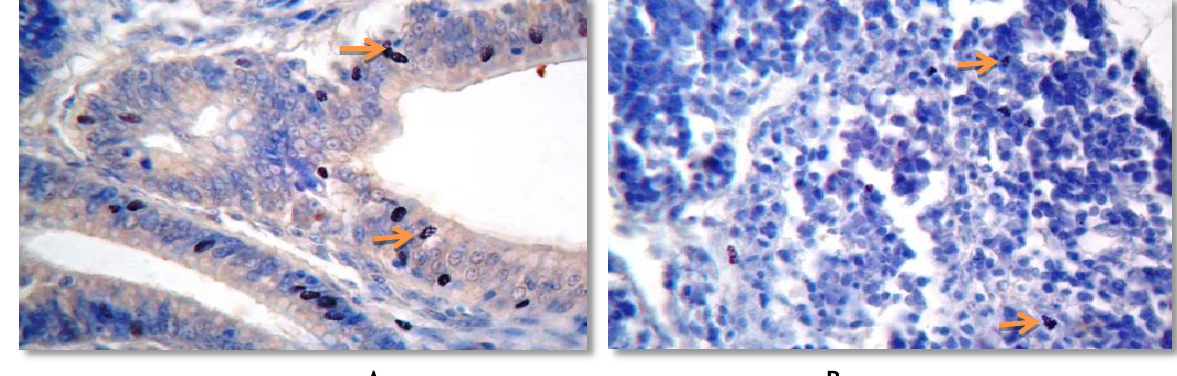
A B Figure,5: Macrophages in paraffin embedded sections (5µm) were identified by using an anti-chicken monocyte- macrophage mouse monoclonal antibody (KUL01) and an HRP –conjugated secondary antibody A:Macrophages in the duodenum of heat stressed treated 24 days old chick G1. Immunopositive cells are purple-brown ( ).B: Macrophages in the bursa of fabricius of heat stressed treated with β-glucan 24 days old chick G1. Immunopositive cells are red-brown ( ) 100 X.